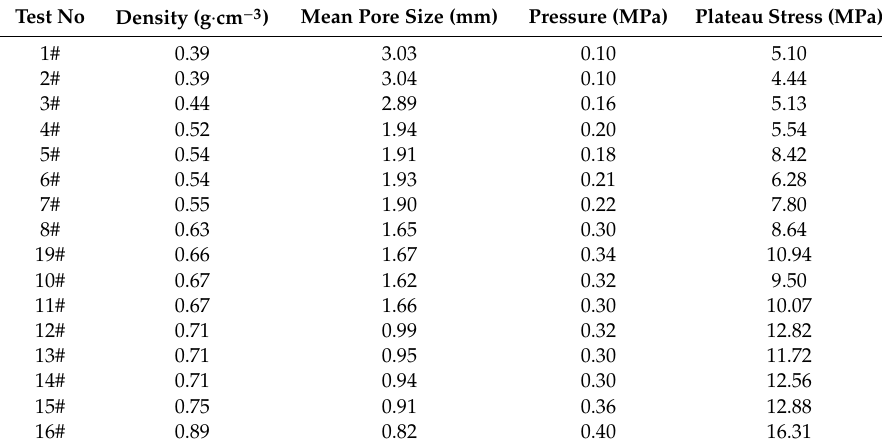
Figure 1. Equipment for the fabrication of aluminum foam under increased pressure: 1—stirring stand; 2—speed controller; 3—resistance furnace; 4—stainless steel tube; 5—graphite blade; 6—stainless steel crucible; 7—pressure control system. Table 1. The parameters of aluminum foams.